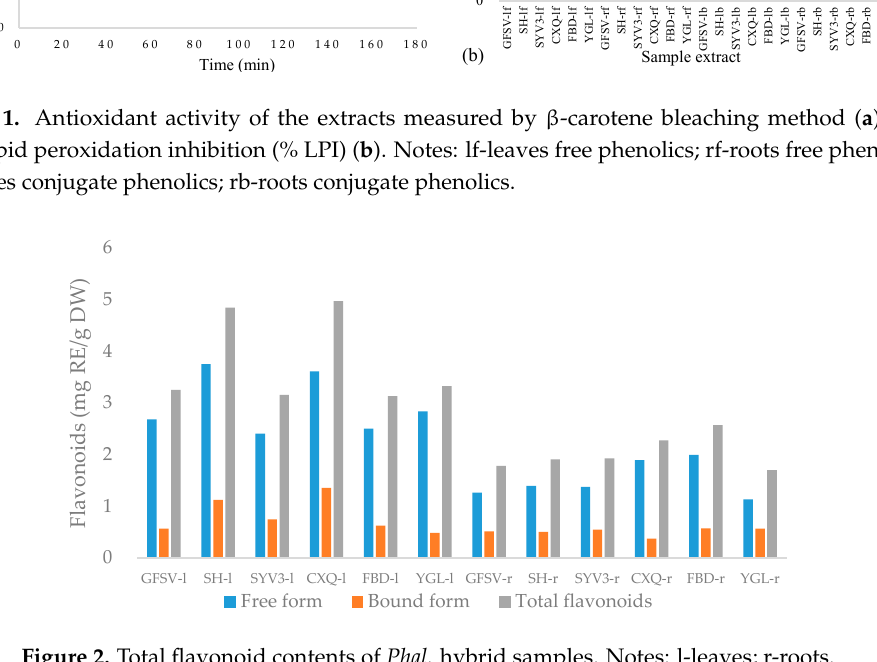
Figure 2. Total flavonoid contents of Phal. hybrid samples. Notes: l-leaves; r-roots.